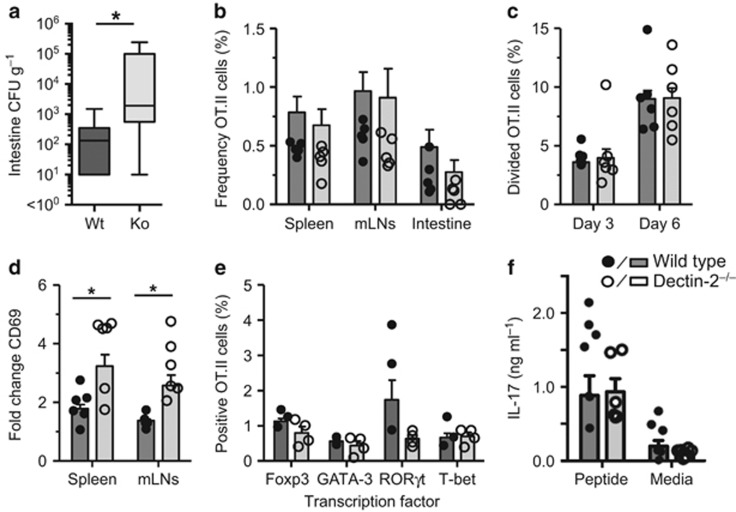
Dectin-2 is not required for antigen-specific CD4+ T-cell responses in the GI tract. WT (filled bars/circles) and Dectin-2 KO (light gray bars/circles) mice were analyzed as described for Dectin-1 KO mice for (a) intestinal fungal burdens (WT n=13, KO n=12), (b) frequency of OT.II cells (WT n=11, KO n=10), (c) division (WT n=12, KO n=10), (d) activation (WT n=11, KO n=10) and (e, f) polarization of OT.II cells in the mLN (WT n=6, KO n=4) at day 3 post infection. Bar charts show pooled data from three experiments; overlaid dot plot shows a representative experiment. *P<0.05.